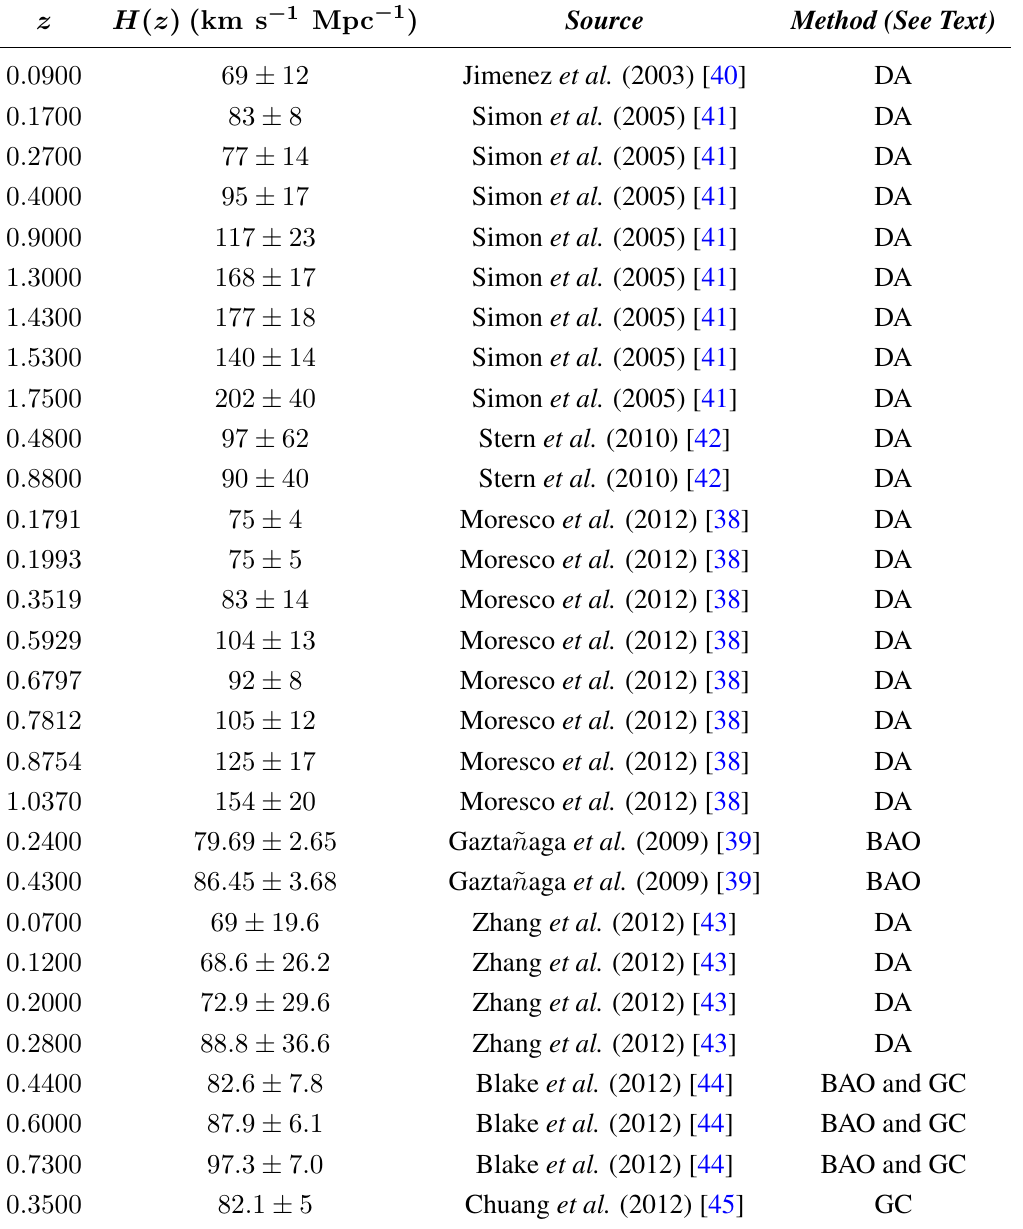
Table 1. Available Hubble parameter data H(z), from various sources, obtained with different